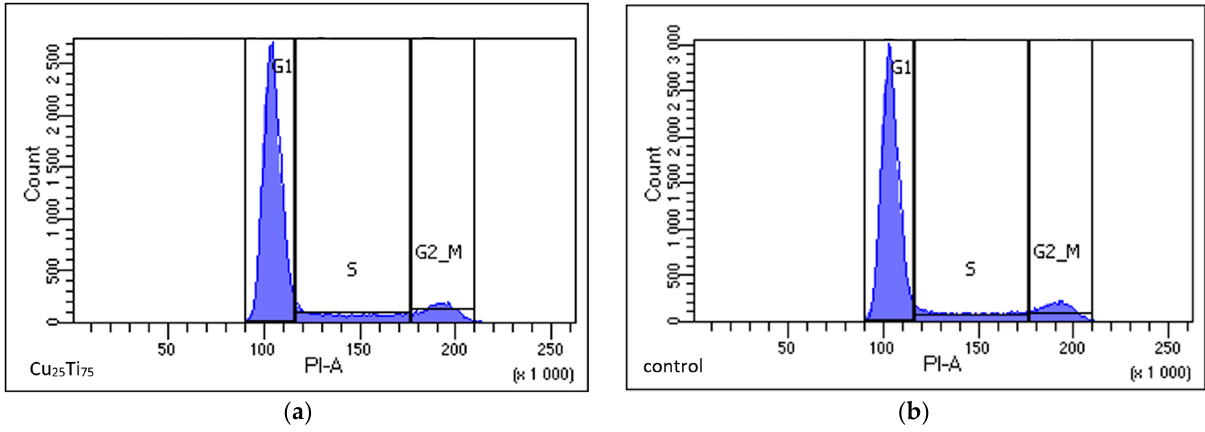
Figure 7. Distribution of Balb/C cells in the cell cycle phase: ( a ) cells exposed to the Cu 25 Ti 75 film extract, ( b ) unexposed cells (control).